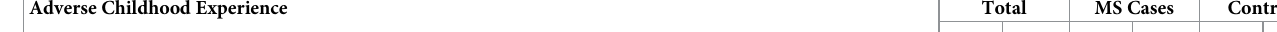
Table 1. Definition and baseline prevalence of adverse childhood experiences reported by adult multiple sclerosis (MS) cases and controls in the Kaiser Permanente Northern California MS Research Program, 2006–2014 (n = 2607). Adverse Childhood